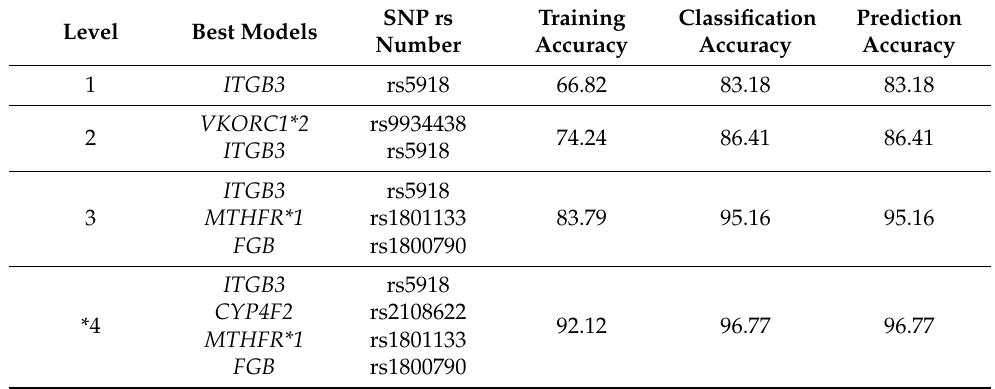
Table 8. Summary table for MDR fit with three-way split validation (k = 4).